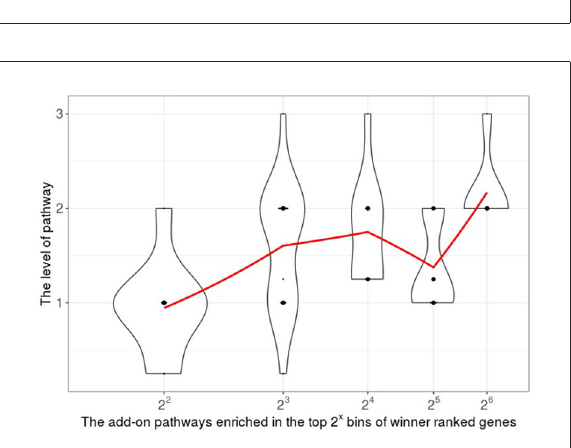
FIGURE11 The correlation between the add-on pathways enriched in the top 2 x bins and the bin size. The violin plot shows the pathway level distribution. The red points connected by solid red lines are the means of pathway